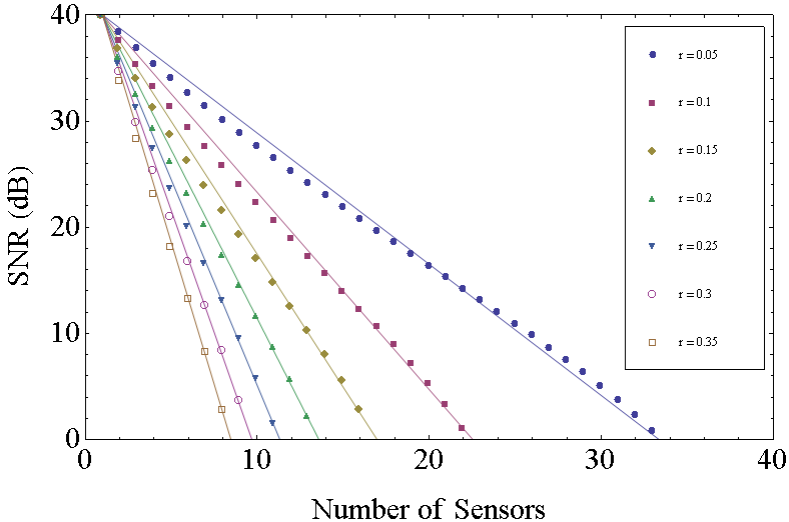
Figure 1. SNR degradation due to the increase of number of FBG